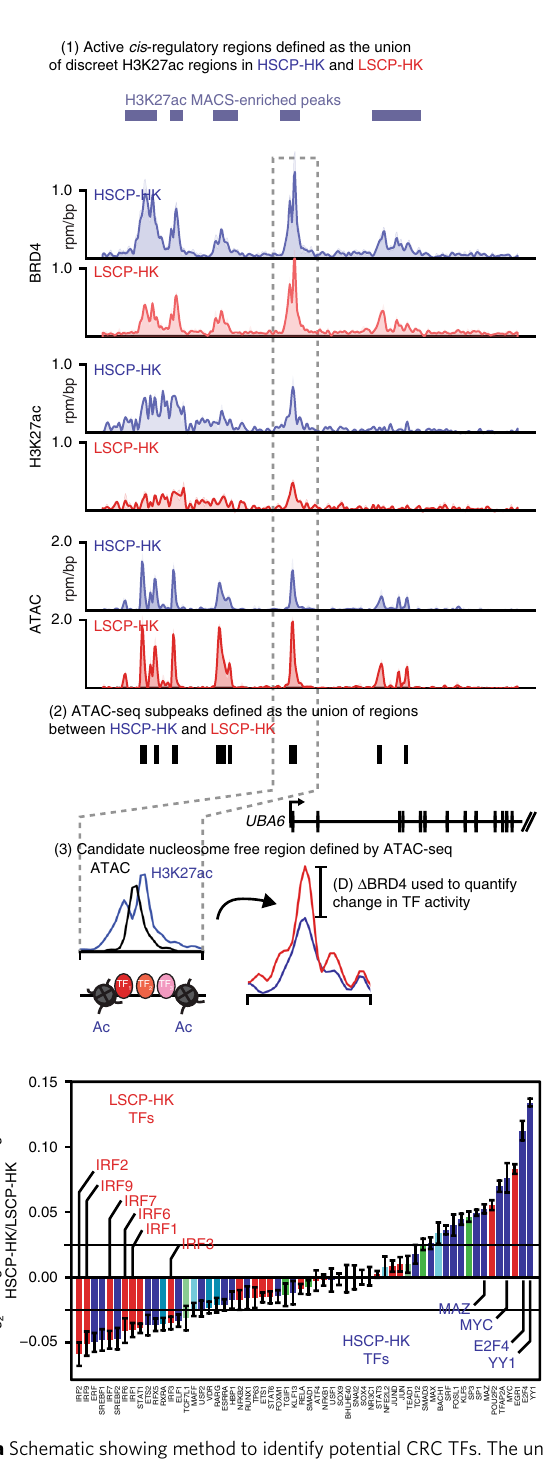
Fig. 3 Changes in TF core regulatory circuitry between HSCP-HKs and LSCP-HKs. a Schematic showing method to identify potential CRC TFs. The union of active genes and H3K27ac sites in both HSCP-HKs and LSCP-HKs was formed in order to create the overall active cis -regulatory landscape for HKs. Subsequently, trans factors and cis -regulatory elements within the HK regulatory landscape showing LSCP or HSCP speci fi c activity were identi fi ed, resulting in network of 60 candidate CRC TFs. Each TF node is colored based on Markov Chain Linkage clustering. Solid and dashed edges represent experimental and predicted protein – protein interactions, respectively, as determined by the StringDB protein – protein interaction database. b Tracks of BRD4 and H3K27ac ChIP-seq as well as chromatin accessibility (ATAC-seq) signal at UBA6 genomic locus with schematic detailing how ATAC-seq peaks are used for TF motif searching followed by quanti fi cation of proximal changes in BRD4. c Schematic showing how BRD4 IN and OUT degree are calculated for each CRC TF. d Ranking of the fold change in BRD4 OUT degree for all CRC TFs in HSCP-HK over LSCP-HK. Error bars represent 95% CI of the mean as determined by resampling with replacement (1000